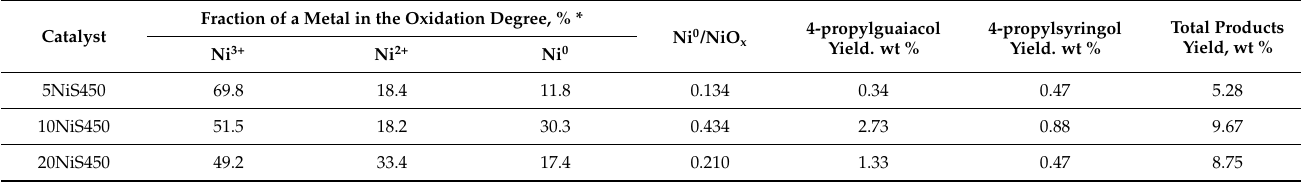
Table 6. Influence of catalyst surface nickel electronic state on the product